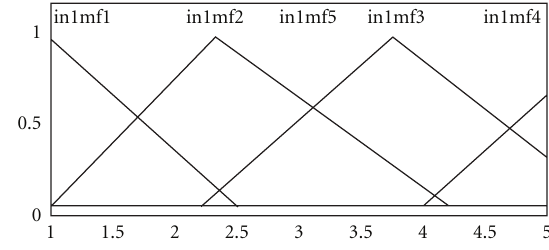
Figure 10: GA ANFIS controller input variable “ e ”.